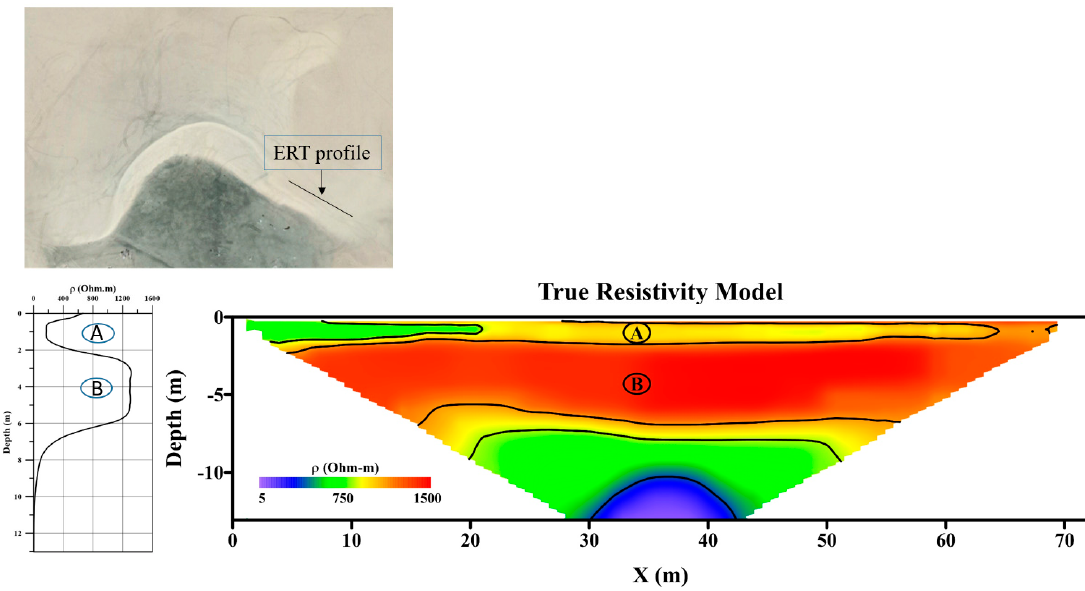
Figure 10. Electric resistivity tomogram (ERT) and resistivity profile of the dune limb, showing four zones of the electrical resistivity.